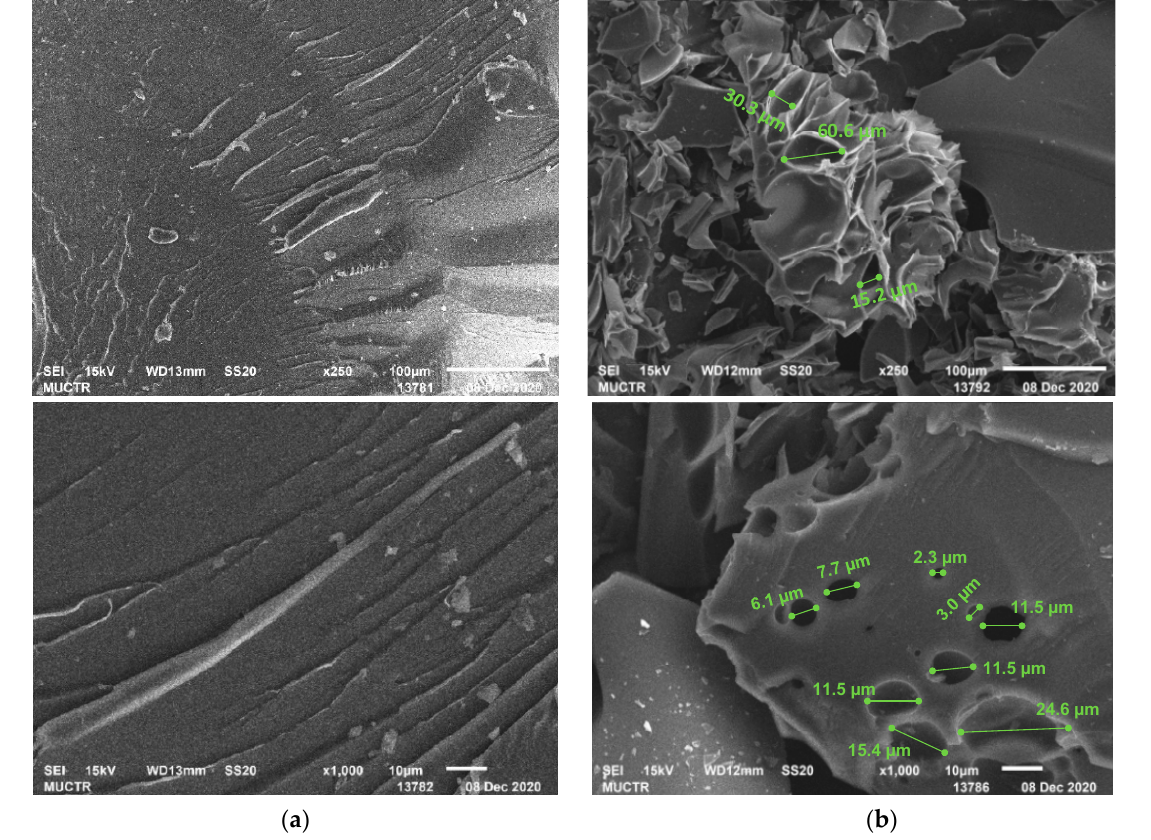
Figure 14. SEM analysis of polybenzoxazine polyP-q ( a ) and char yield ( b ) surfaces. It is also known that halogen radicals compete for the radical species HO · and H · that are critical for flame propagation [49,50]. Thus, the higher fire resistance of polyP-q compared to polyP-d can be explained by two factors. The first factor is the release of low molecular weight products, such as CO 2 , NO 2 , CH 3 Cl and HClO, which cause system cooling and removing of high-energy HO · and H · radicals. The second factor is the formation of the char layer on the polymer surface, which prevents oxygen penetration into the bulk of the sample and thereby stops combustion.